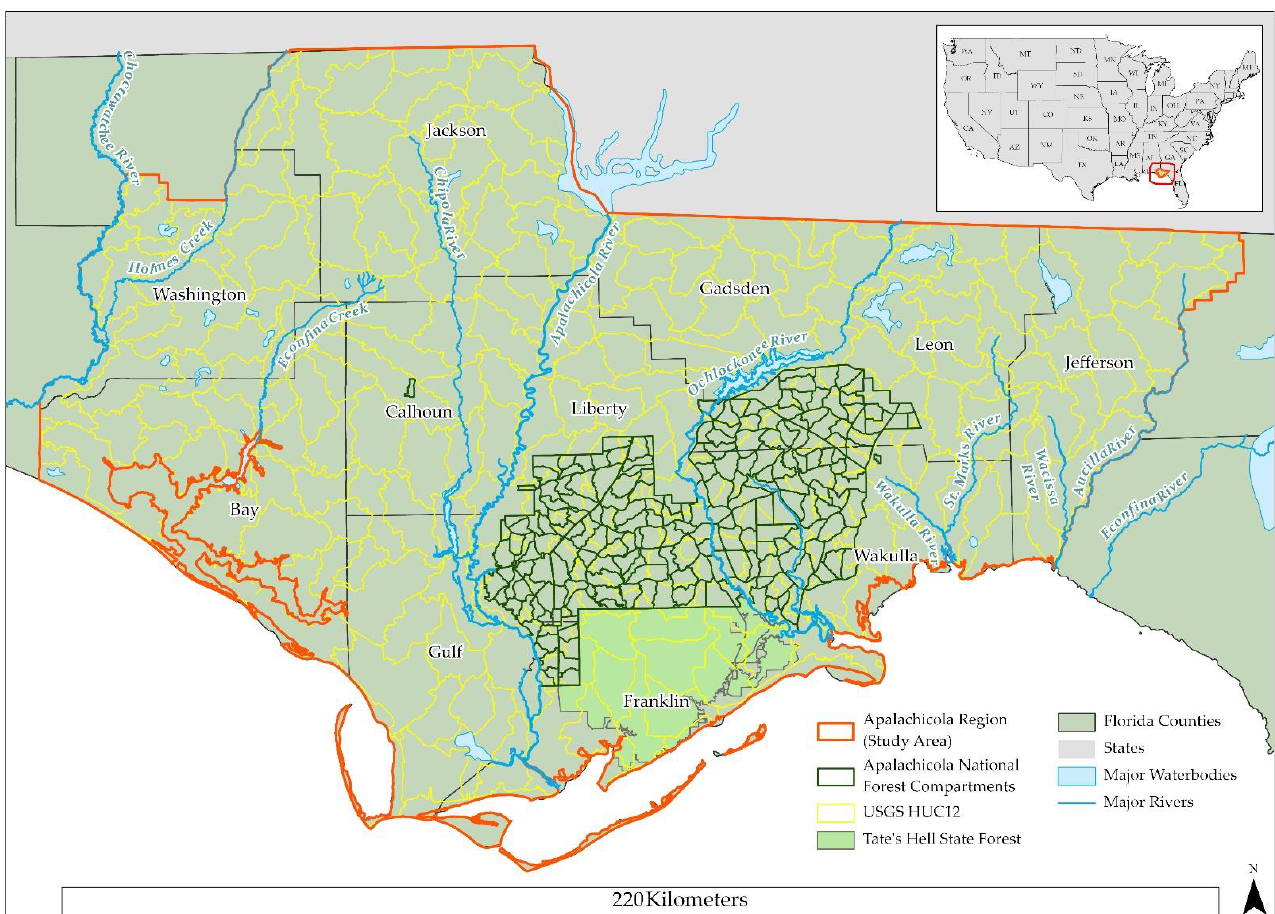
Figure 1. Map of the Apalachicola Region within the state of Florida. Apalachicola National Forest management compartments and USGS HUC12s are outlined in green and yellow, respectively.